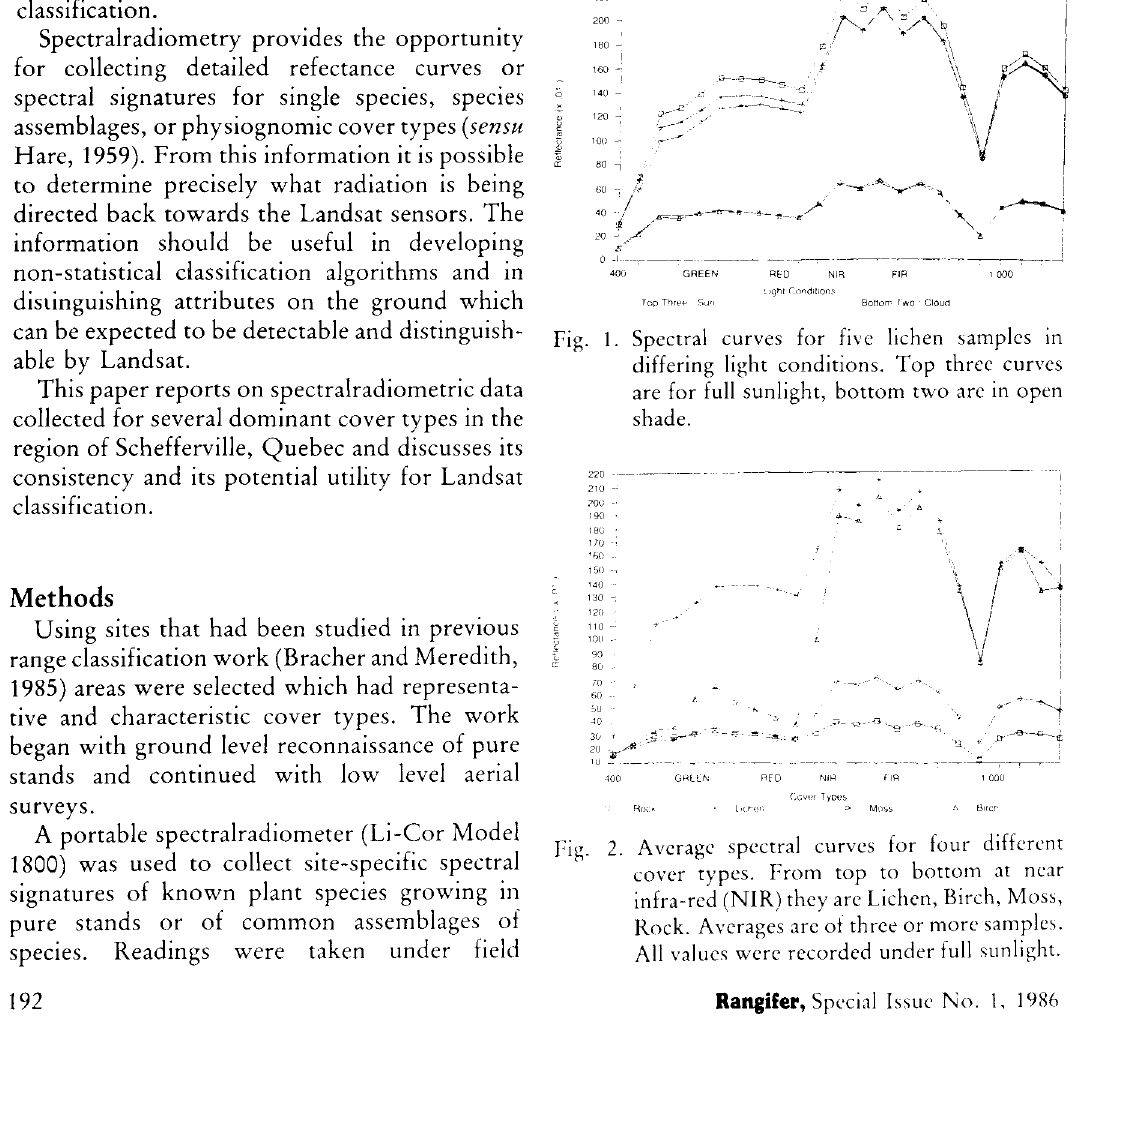
Fig. 1. Spectral curves for five lichen samples in differing light conditions. Top three curves are for full sunlight, bottom two are in open shade.